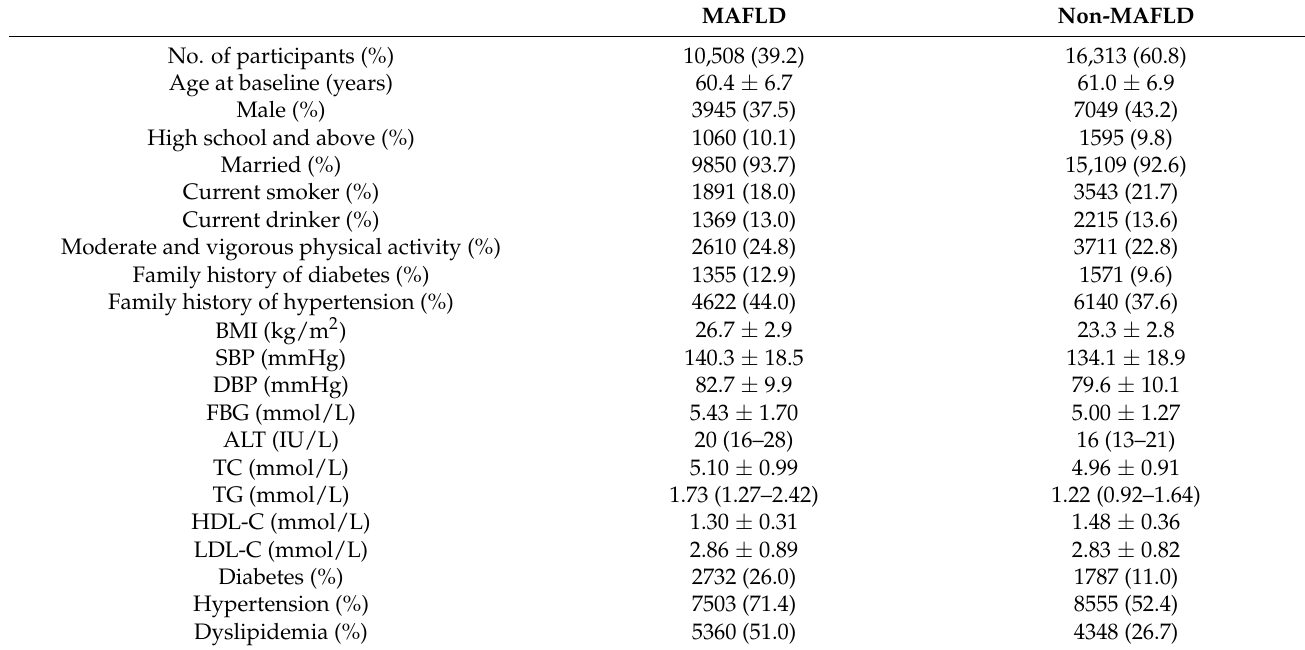
Table 2. Characteristics of 26,821 participants according to MAFLD